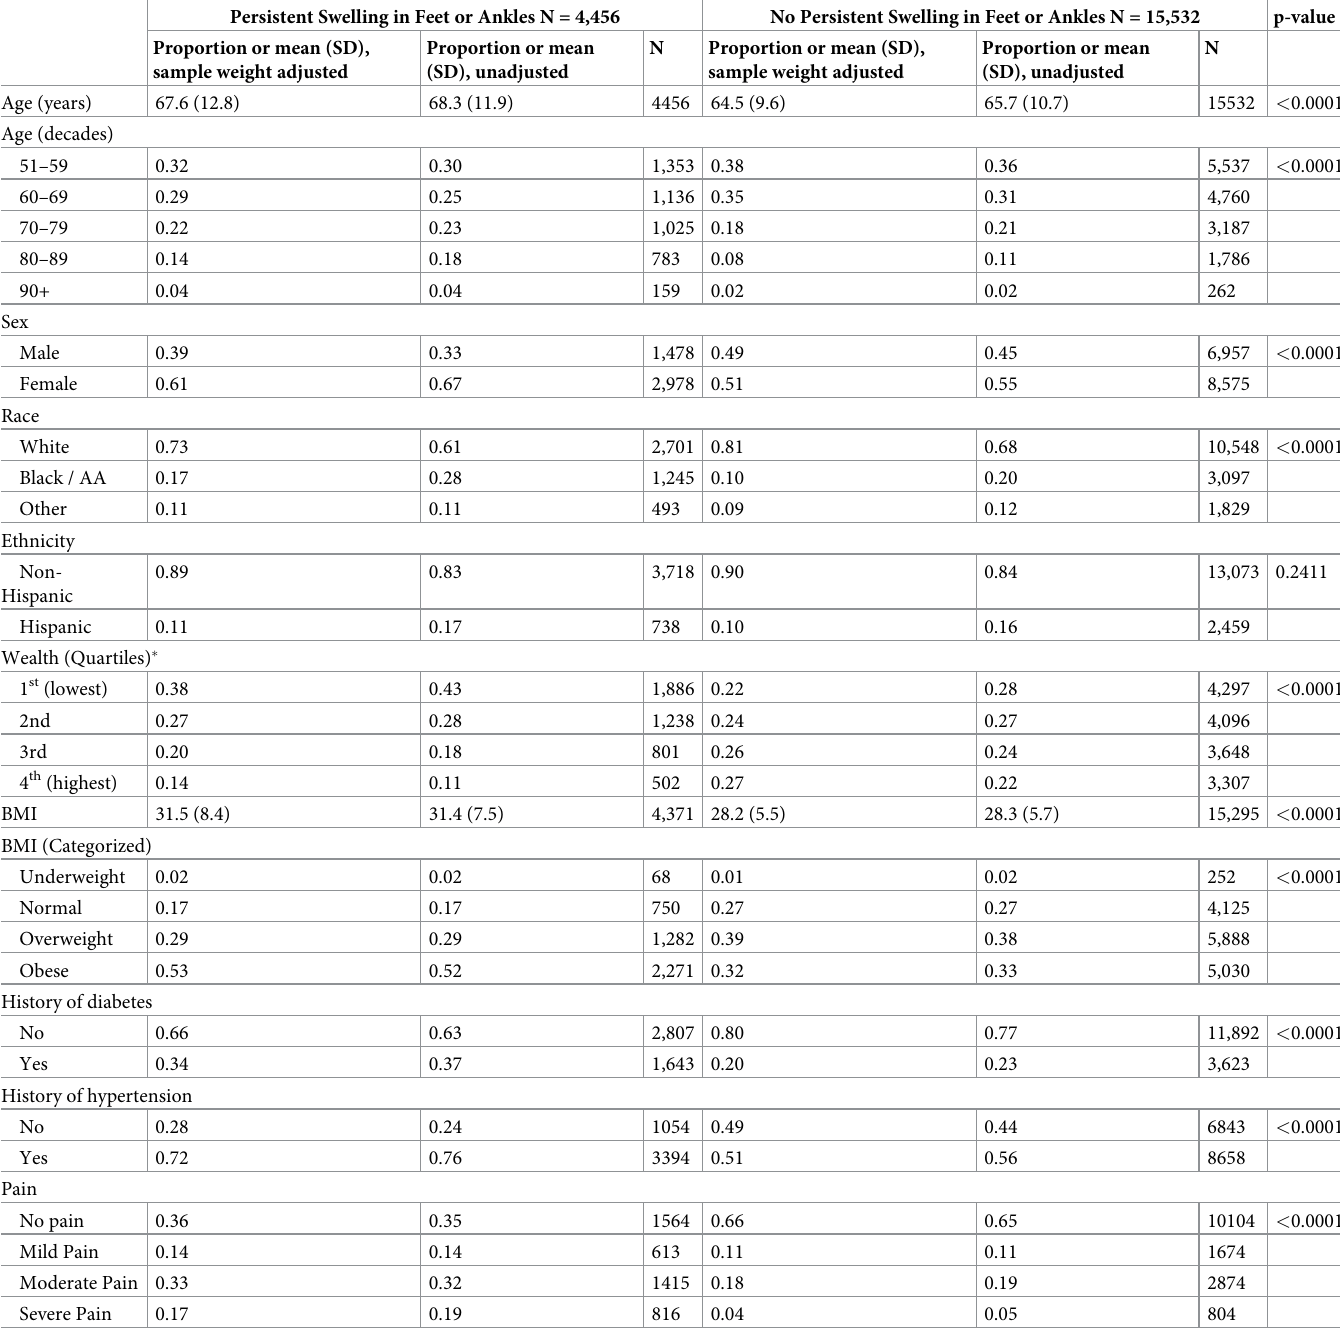
Table 1. Demographic and clinical characteristics (age 51+, 2016 HRS